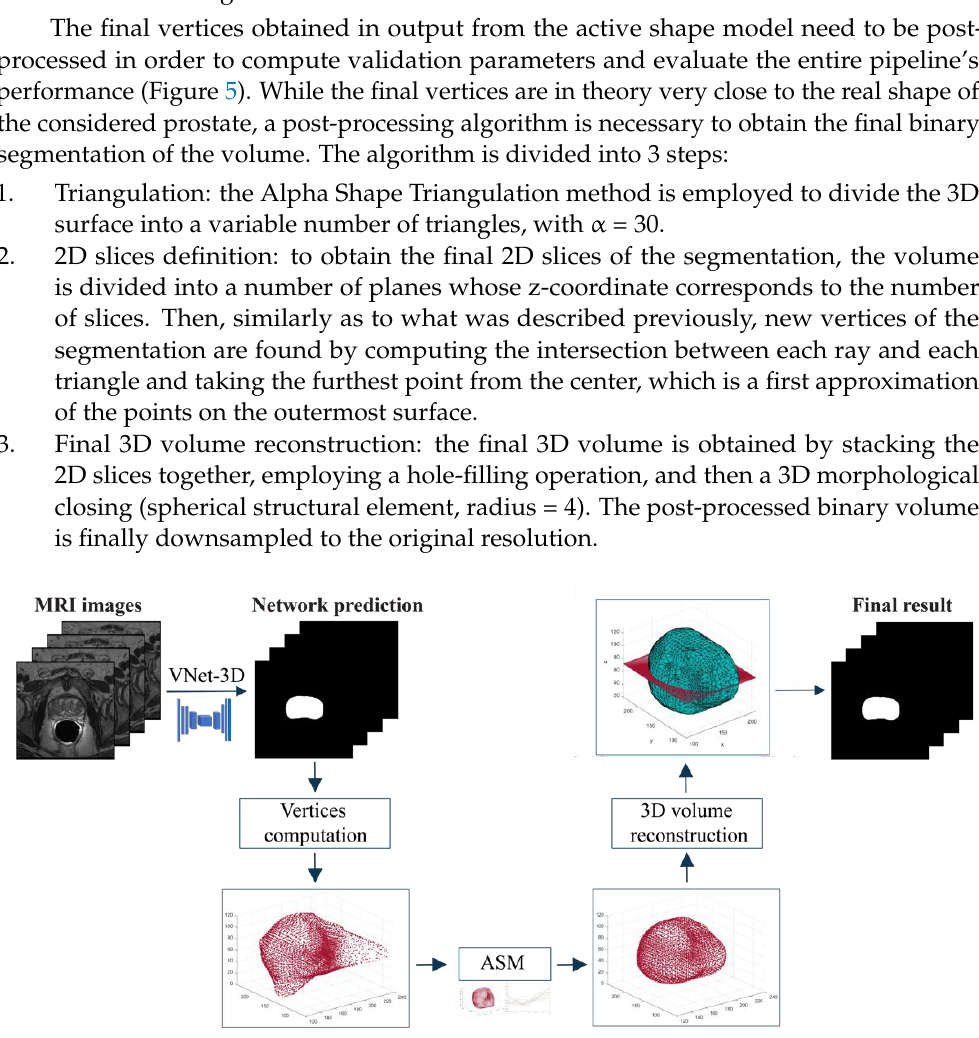
Figure 5. Schematic representation of the proposed algorithm. A first segmentation is provided by the VNet-T2. Then, the ASM model is applied to refine the volumetric segmentation. Finally, triangularization is performed to obtain the binary masks.